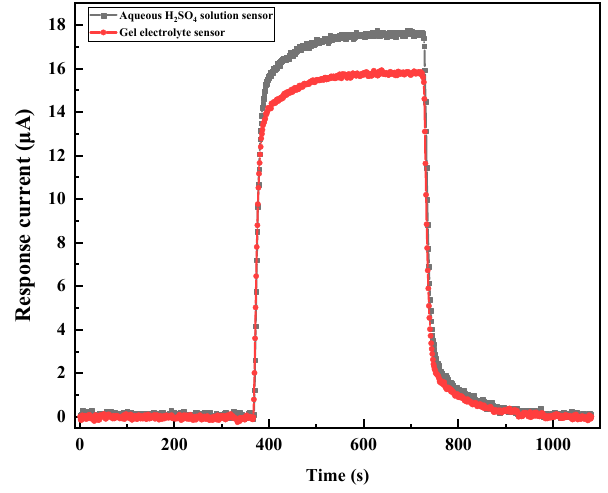
Figure 9. Transient response curves of the sensors to 200 ppm CO.